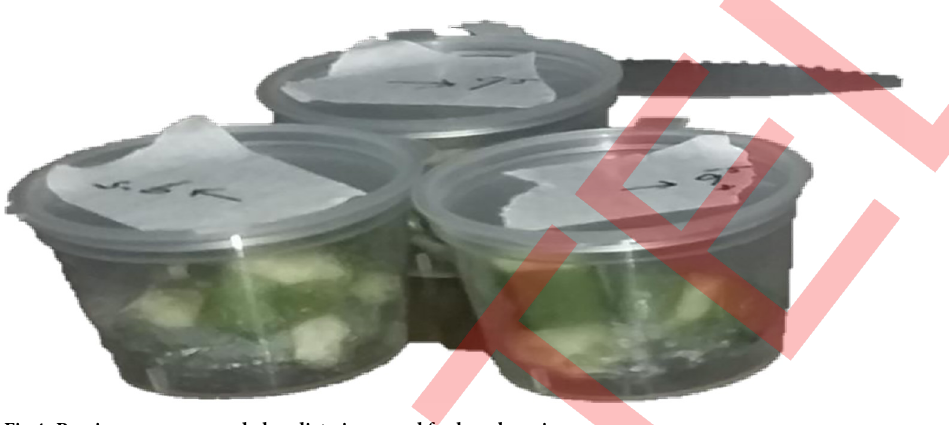
Fig 4. Rearing cups possessed okra diet pieces used for larval rearing.